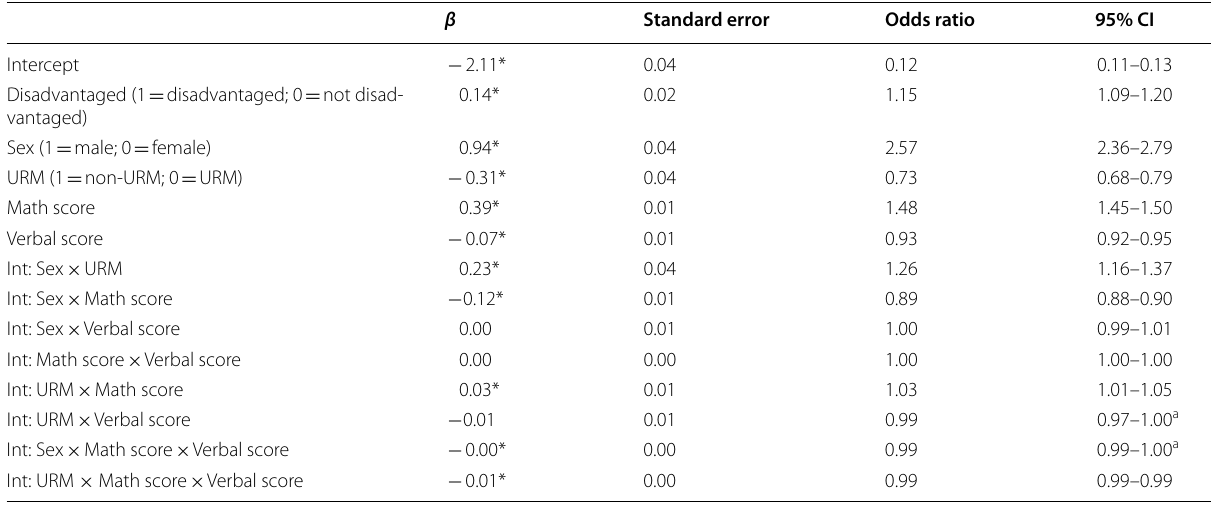
* p < .001. The numbers were rounded to 2 decimal points. Int